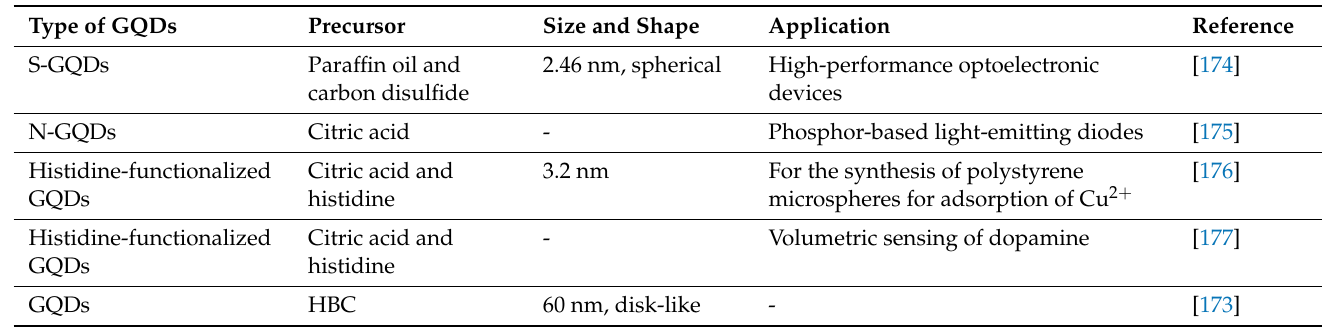
Table 3. The soft template methods for the preparation of GQDs.